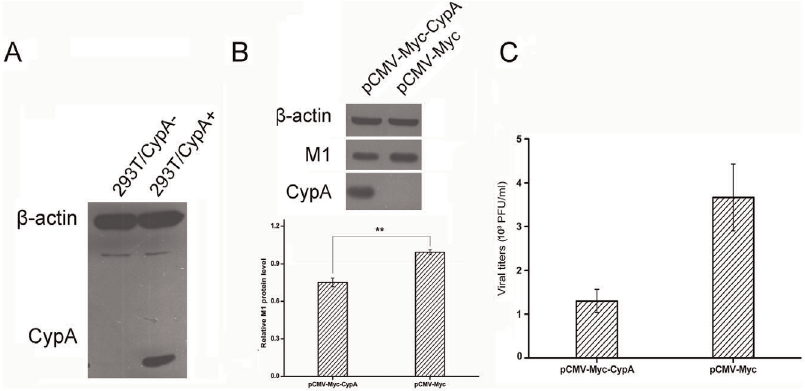
Figure 2. CypA inhibits the replication of influenza virus in CypA rescued cells. A: Western blot assay of the amount of CypA in both 293T/ CypA + and 293T/CypA 2 cell lines. B: Re-expression of CypA in 293T/CypA 2 cell line. 293T/CypA 2 cells were transfected with plasmids (4 m g) encoding Myc-tagged WT CypA or pCMV-Myc as control. At 36 h p.t., transfected cells were infected with WSN virus (MOI=0.1). At 16 h p. i., total cell lysates were detected by Western blot using anti-M1, anti-Myc and anti- b -actin. The protein levels of M1 were quantified. Data are presented as 6 SD from three independent experiments. Significant differences (P , 0.01, t-test) are indicated by two asterisks. C: Re-expression of CypA in 293T/CypA 2 cell line inhibited influenza virus replication. The media were collected and assayed for virus titers by plaque assay. The data represent the means of three independent experiments.